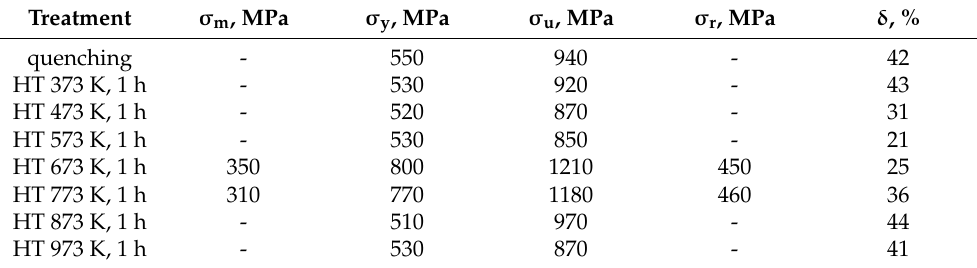
Figure 19. ( a ) Bright- and ( b ) dark-field TEM images of the microstructure, and ( c ) the correspond- ing SAED pattern (SD 1 µm), taken from the Ti 49.5 Ni 50.5 alloy after its MPR by 30%.